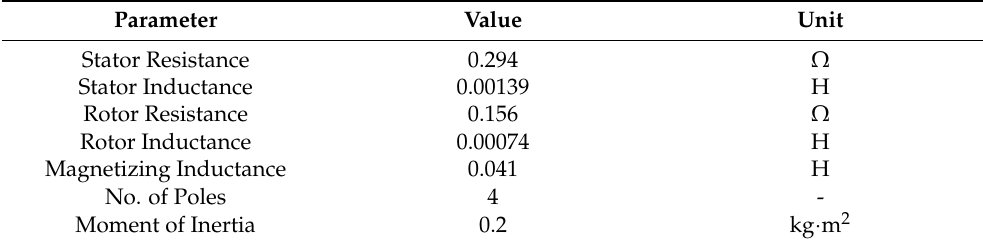
Table 1. Parameters of the Simulated 3-Phase Induction Motor.